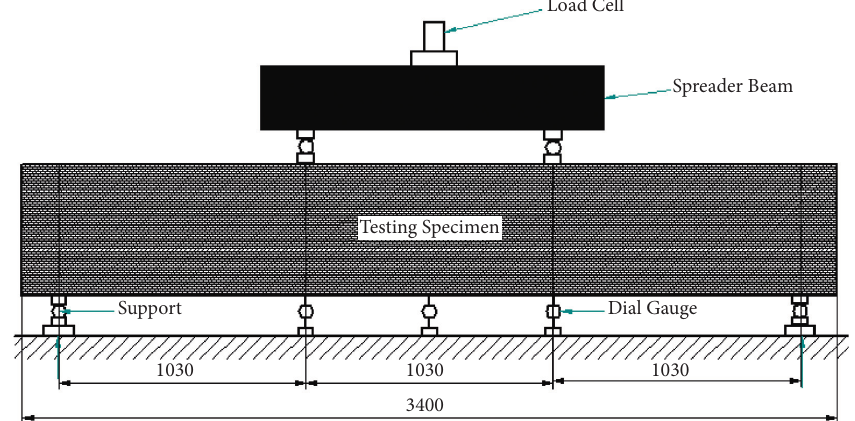
Figure 3: Details of experimentation.